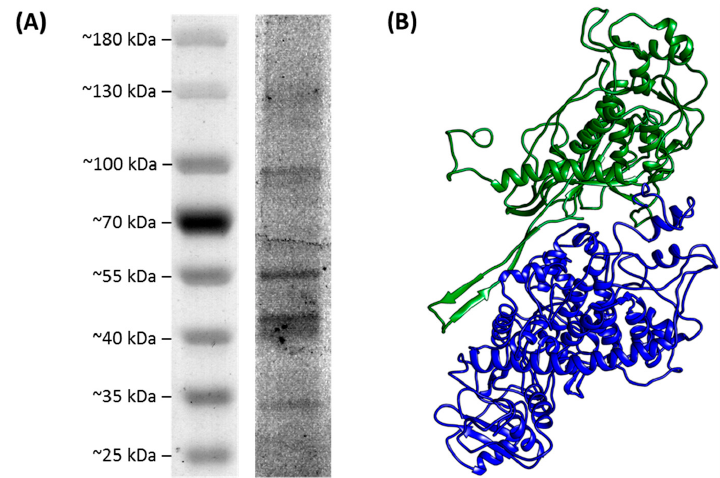
Figure 2. Schematic representation of the genomic organisation of LbQV-1. The LbQV-1 genome consists of four dsRNA segments, 4917, 4543, 4490, and 4048 bp in size, each containing one ORF Figure 4. ( A ) SDS-PAGE pattern and modelling of LbQV-1 structural proteins. Proteins in a purified Figure 2. ( A ) SDS-PAGE pattern and modelling of LbQV-1 structural proteins. Proteins in a purified shown as an open box flanked by 5'- and 3'-UTRs. A pink box on dsRNA 3 represents the RdRP preparation of LbQV-1 were separated using a 4 – 25% gradient SDS-PAGE, stained with SYPRO® preparation of LbQV-1 were separated using a 4–25% gradient SDS-PAGE, stained with SYPRO ® Ruby Ruby and visualized by using the Fujifilm FLA-5000 fluorescent image analyser. The prestained domain. A blue and a green box on dsRNA 2 and dsRNA 4, respectively, illustrate the domains of and visualized by using the Fujifilm FLA-5000 fluorescent image analyser. The prestained protein protein ladder molecular weight sizes are shown to the left of the gel, following digitalization with the putative capsid proteins that were structurally modelled, as shown in Figure 4. ladder molecular weight sizes are shown to the left of the gel, following digitalization with EPSON EPSON Scan. ( B ) The partial structures and interaction between the two LbQV-1 structural proteins Scan. ( B ) The partial structures and interaction between the two LbQV-1 structural proteins were were predicted and visualized; the green and the blue protein domains are encoded by dsRNA 2 and Table 1. Features of the LbQV-1 dsRNA segments 1 – 4 and comparisons with other known and dsRNA 4, respectively. predicted and visualized; the green and the blue protein domains are encoded by dsRNA 2 and dsRNA suspected quadriviruses. 4, respectively.